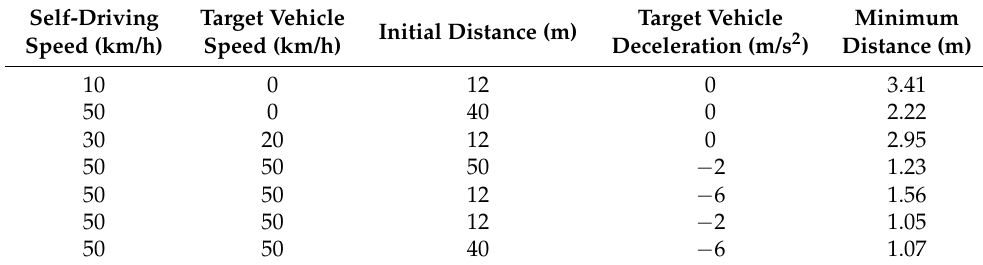
Table 8. Simulation test